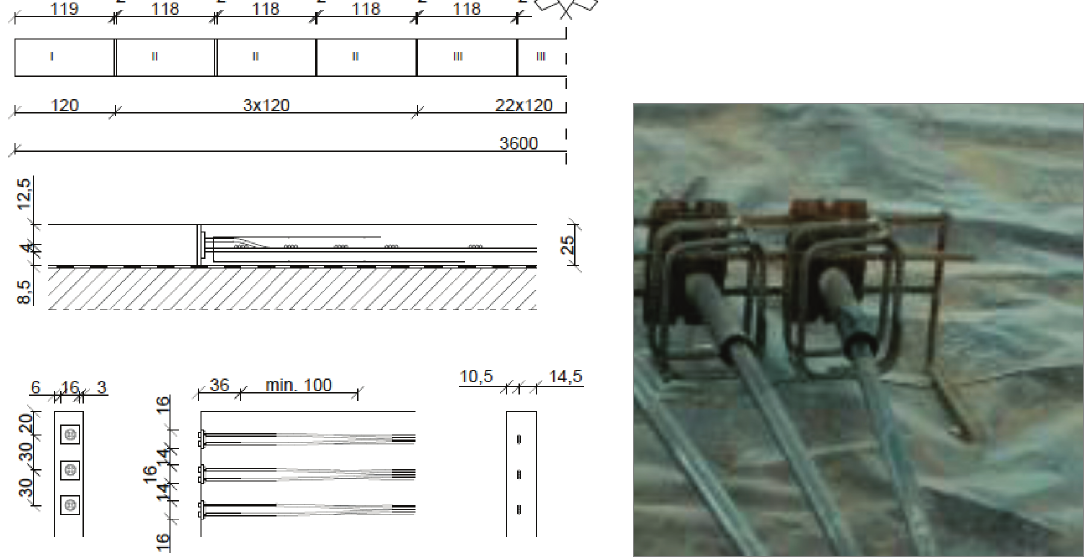
Fig. 3. Division of prestressed slab into sections, acc. to load types I, II and III, and detail of connecting prestressed slabs with a jacking gap, and a view of preliminary stabilised tendon terminals, dimensions in cm, descriptions in the text [own study, photo by A. Seruga]